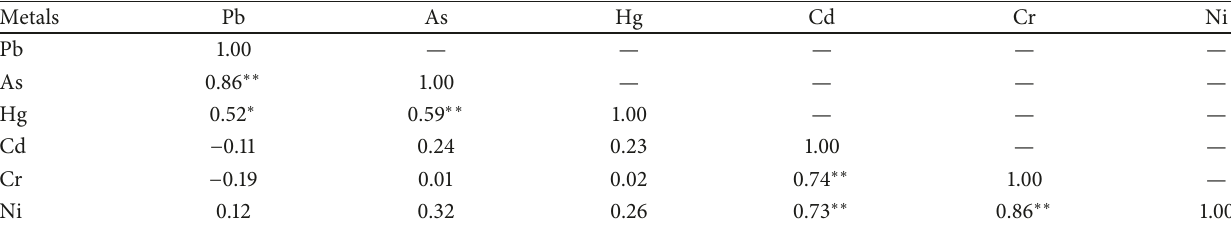
Table 3: Correlation matrices of metal concentrations.